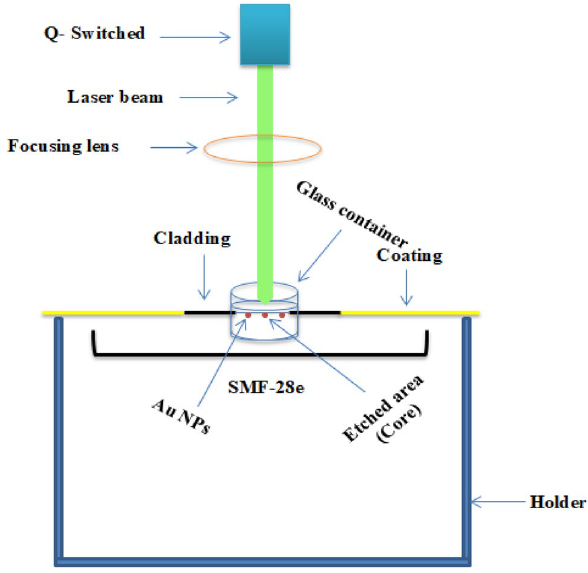
Figure 4. Presents a schematic of the deposition process of Au NPs.